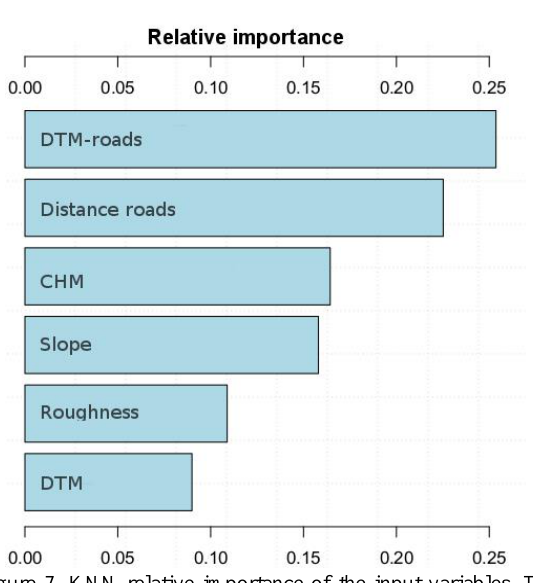
Figure 7. KNN relative importance of the input variables. The x-axis reports the AAD metric.